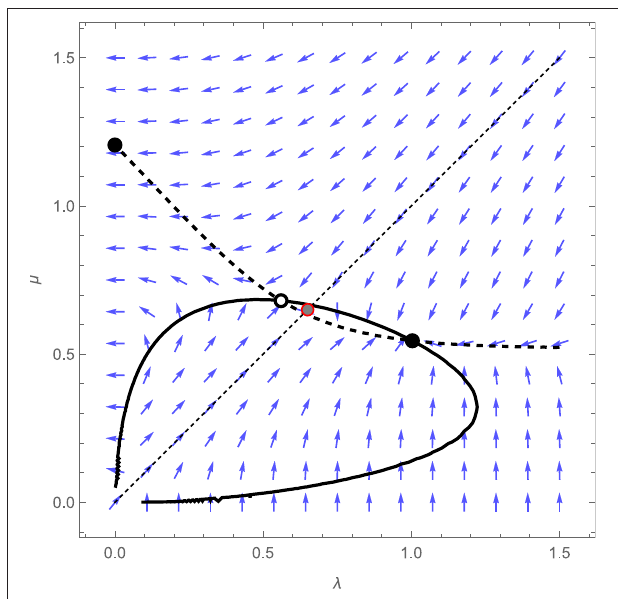
FIGURE 4 | Adaptive dynamics of the extended model described in the main text, when the costs and benefits of feeding are time-dependent, for an illustrative symmetrical case in which λ f = λ m = λ , µ f = µ m = µ , with d f = d m = 0.8, h = 1 and r f = r m = 0.2. The fitness payoff to a parent is equal to bB − cC f or bB − cC m , where B denotes the mean rate at which offspring receive feeds while hungry and C f or C m the mean rate at which the female or male parent visits the young while in a refractory state, with b = 1 and c = 0.2. Blue arrows show the direction of the selection gradient for a population characterized by particular values of λ and µ , thick curves represent the null-clines for λ (solid curve) and µ (dashed curves), while empty and filled circles denote convergently unstable and stable equilibria, respectively. The gray-filled red circle represents the equilibrium outcome of the model when parents cannot respond to one another’s visits (i.e., under the constraint that λ = µ